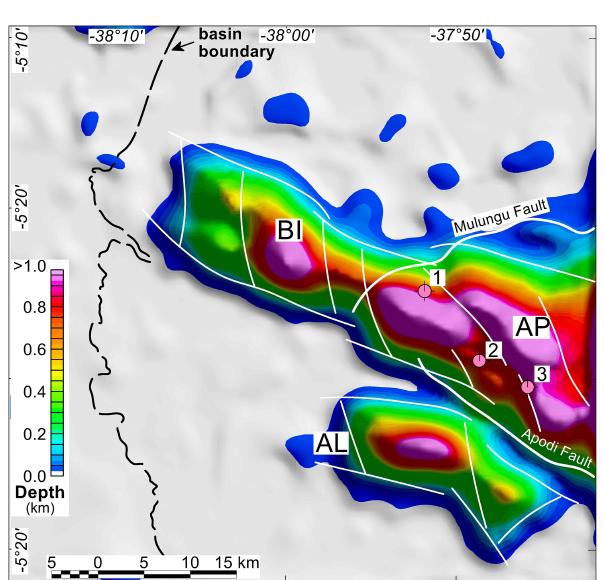
interpreted the depocenters to exhibit an en echelon geome- try and fault segments 35 km